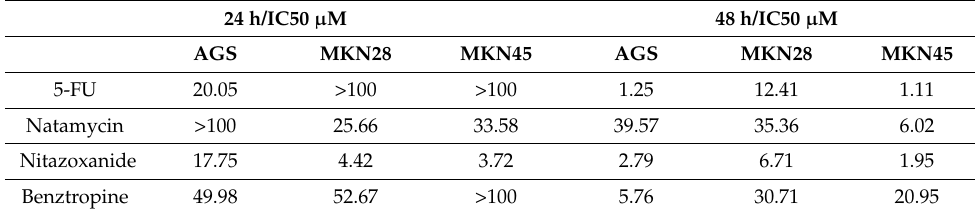
Table 3. IC50 of reference and repurposed drugs in AGS, MKN28, and MKN45 GC cells. 24 h/IC50 µ